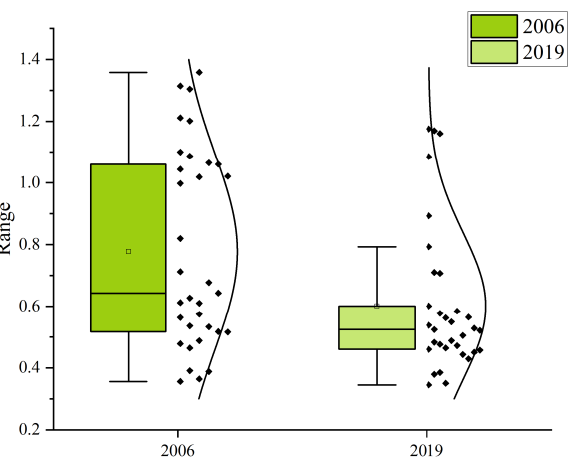
Figure 6. Box chart of carbon emission efficiency with scatter plot and distribution overlay.